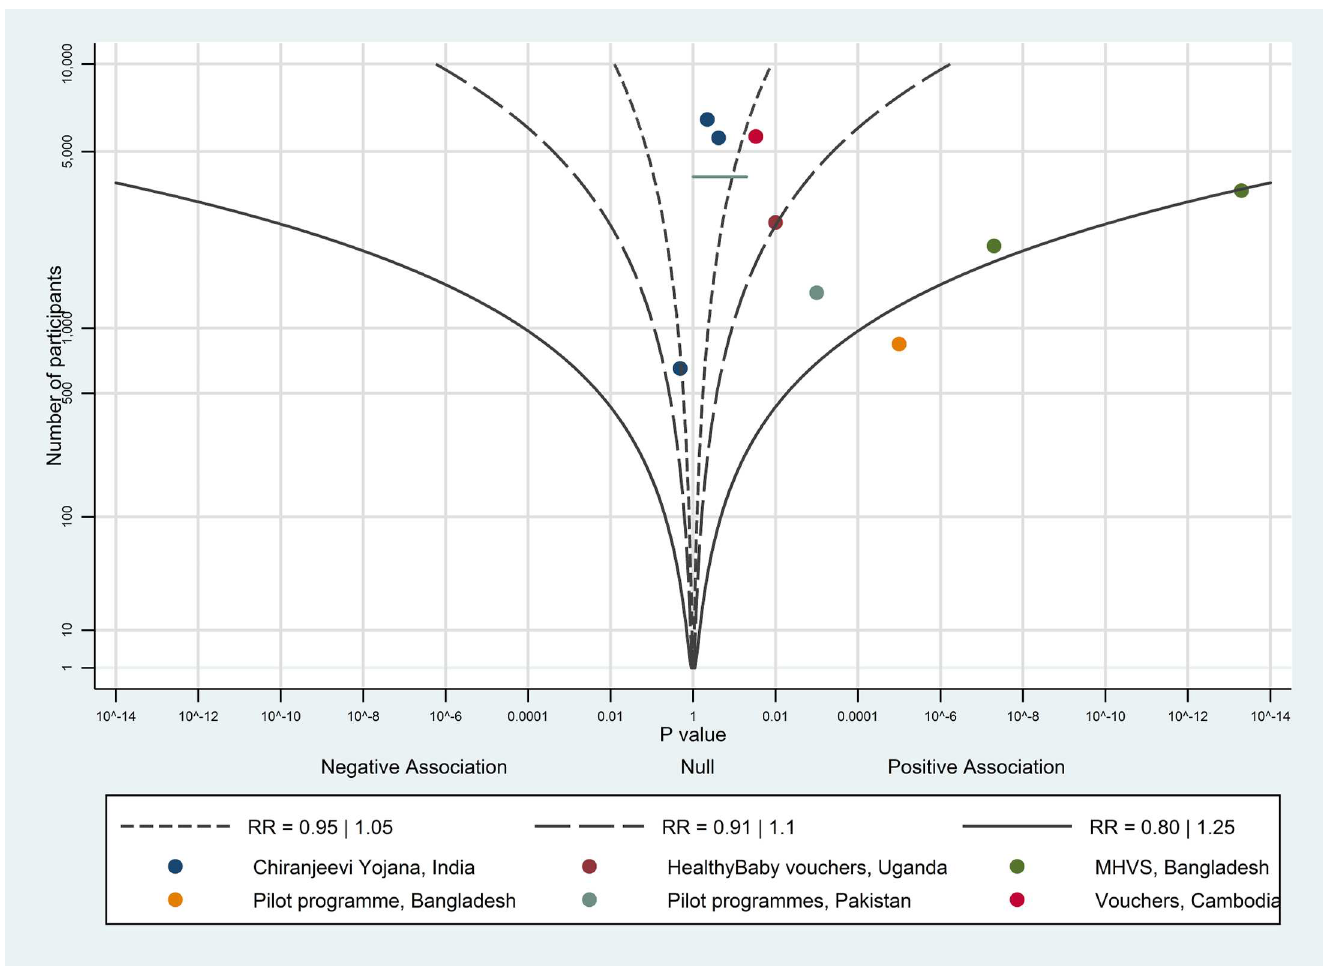
Fig 12. Albatross plot for effect of vouchers for maternity care serviceson uptake of postnatal care. MHVS—Maternal Health Voucher Scheme.